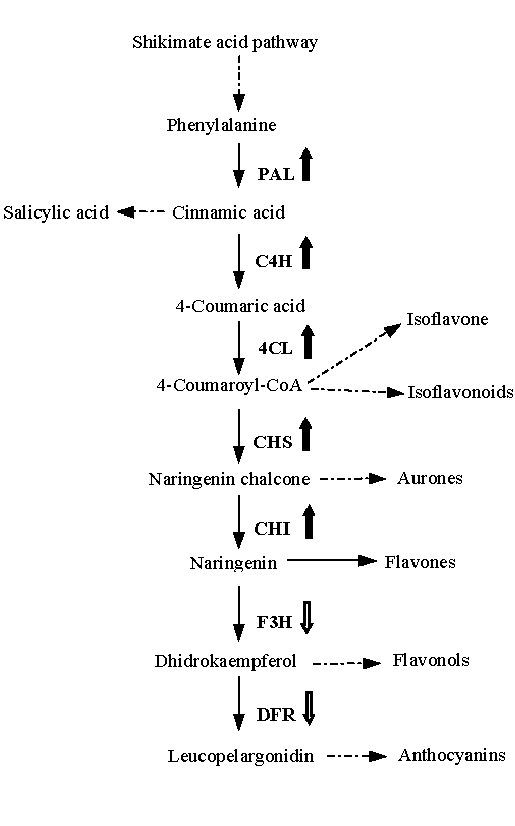
Figure 1. Outline of phenylpropanoid biosynthesis pathways in plants. Solid arrows indicate those single-step reactions; dashed arrows denote several steps. Enzymes are shown in bold. Thick bold arrows show those salt-inducible enzymes and blank thick ones demonstrate salt-repressed enzymes in M. pinnata. Abbreviations: PAL, phenylalanine ammonia-lyase; C4H, cinnamate 4-hydroxylase; 4CL, 4-coumarate:CoA ligase; CHS, chalcone synthase; CHI, chalcone isomerase; F3H, flavanone 3-hydroxylase;